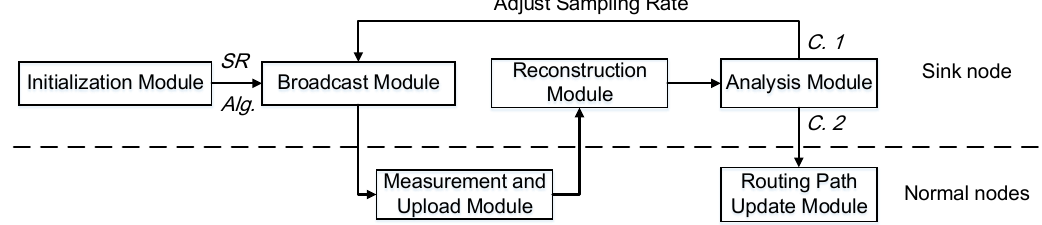
Figure 7. The overview of LESS. The sink node broadcasts the predefined sampling rate and scheduling algorithm, and the normal nodes then measure the link quality and upload the result back to the sink. With the CS technique, the sink node reconstructs the routing paths and analyzes the reconstruction result. From the results, conditions C .1 (current sampling rate is not proper) and/or C .2 (current routing path does not fit) may happen and the protocol goes into corresponding